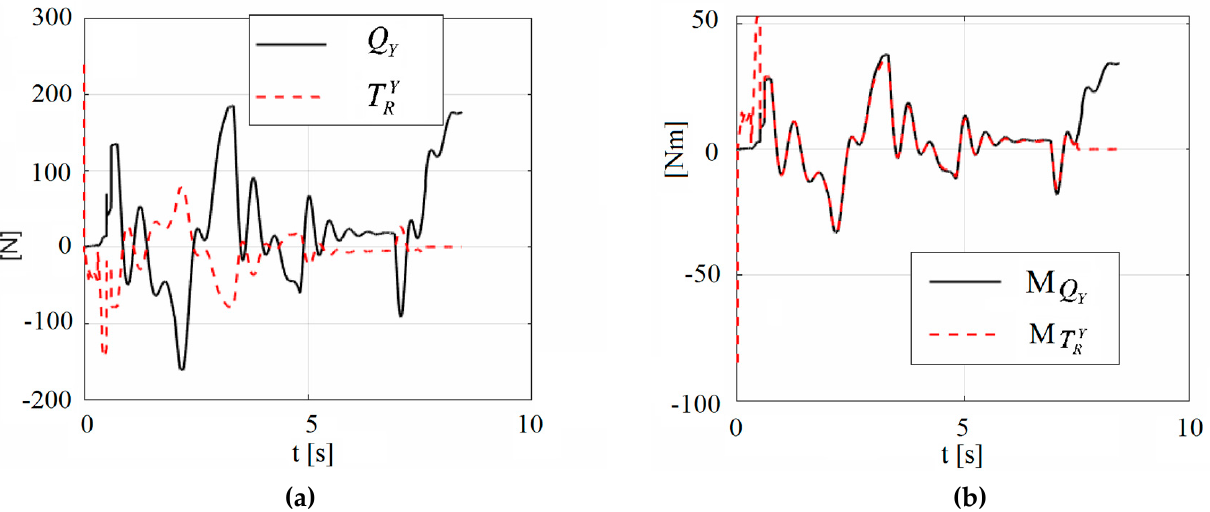
Figure 15. The performed angles of the flight control in the channel of altitude and direction.